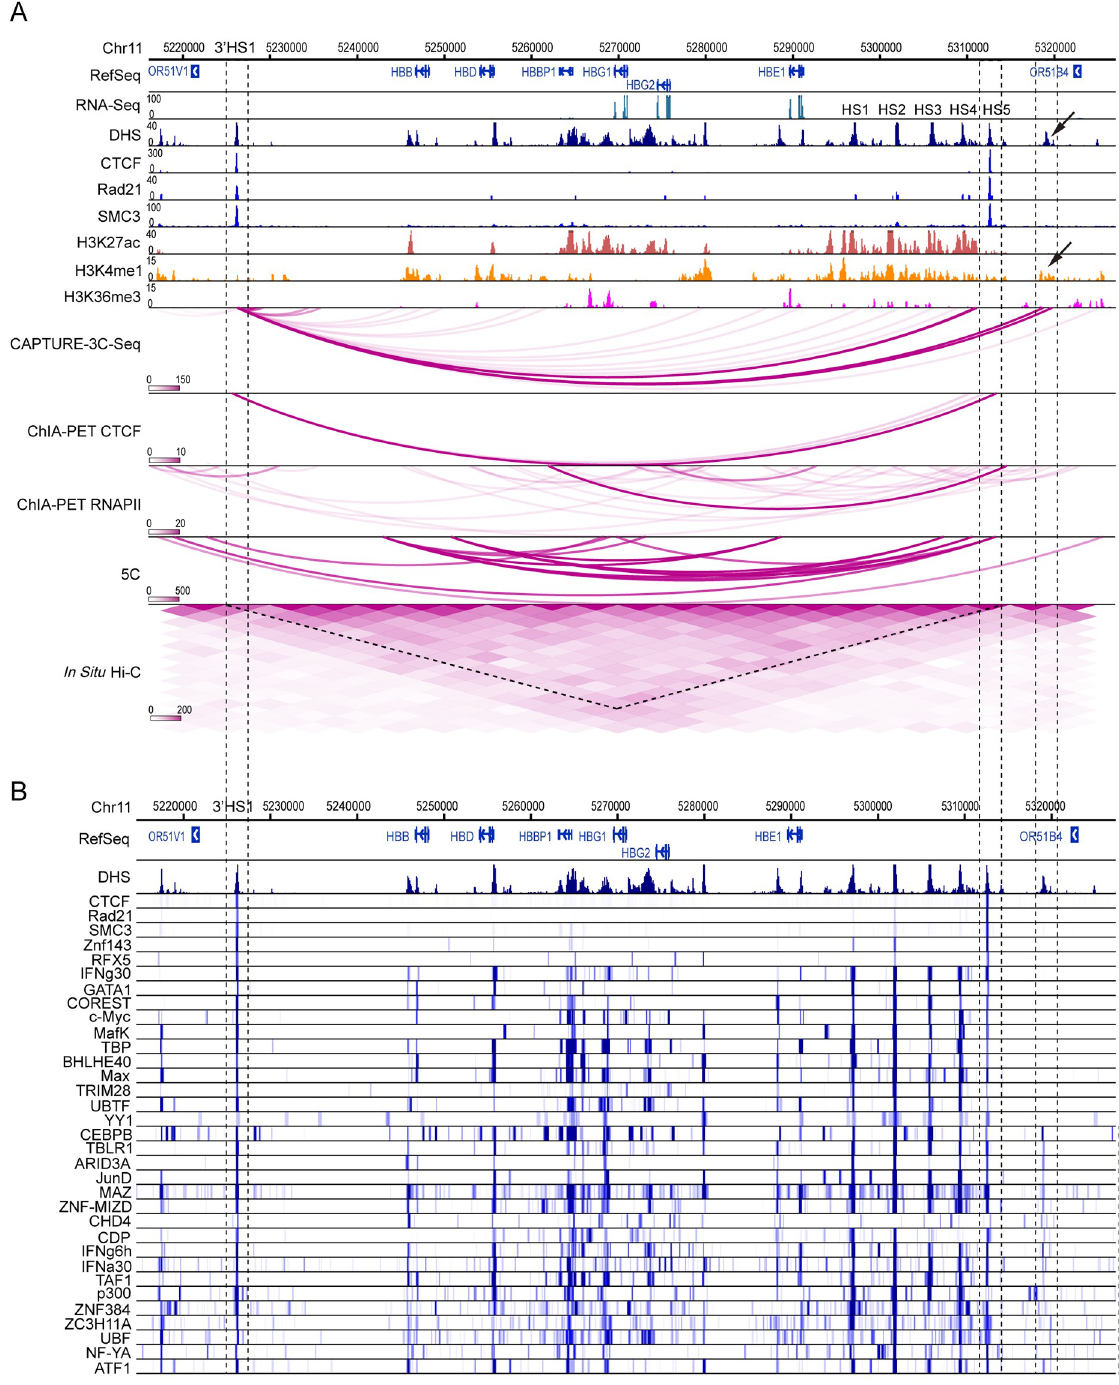
Fig 3. Detecting intra-chromosomal interactions at the 3’HS1 region. A . The identified long-range interactions are shown together with DHS, histone markers (H3K27ac, H3K4me1 and H3K36me3), CTCF, RAD21 and SMC3 binding signals from the ENCODE database. Comparisons with 5C, in situ Hi-C, RNAPII and CTCF ChIA-PET are shown on the bottom. The arrows indicate the peak signals of DHS and H3K4me1 that co-localize with the interactions at the 3’ region of the OR51B4 gene. B . ChIP-seq data of 33 TFs are shown. The right blue bar denotes the 17 TF tracks with strong binding peaks at the 3’ region of the OR51B4 gene (Chr11:5310800–5320000).